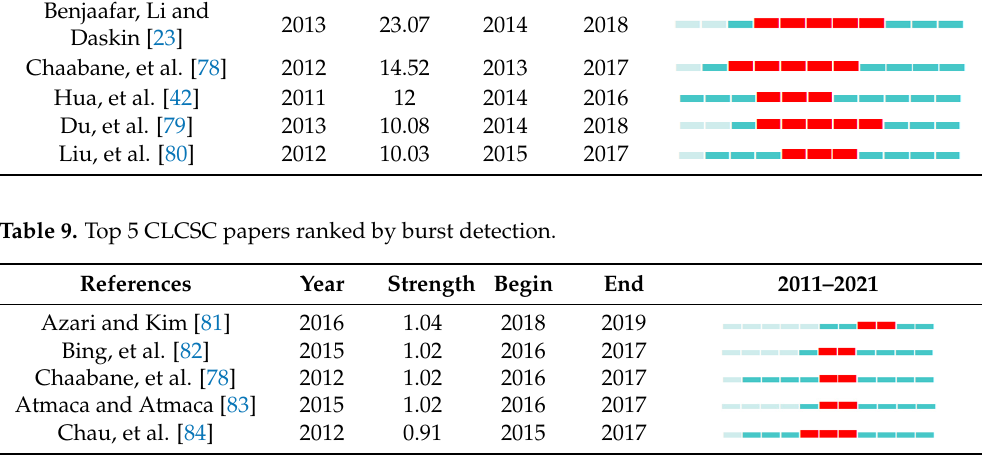
Table 9. Top 5 CLCSC papers ranked by burst detection. References